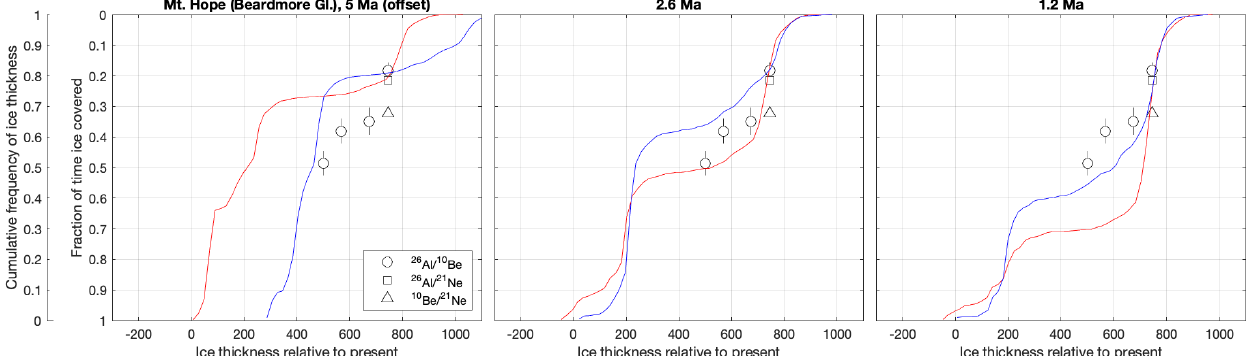
Figure 13. Ice cover frequency estimates for Mt Hope, inferred from multiple-nuclide data and the inversion code of Spector et al. (2020), compared with sensitized and desensitized model CDFs for a site in the centre of the model Beardmore Glacier at a position near Mt Hope (because of the coarse model resolution, the model Beardmore Glacier is not in exactly the same location as the real glacier, so we have chosen an equivalent site in the model). As in Figs. 10 and 11, model CDFs have been offset to align observational and model CDFs at the 80th percentile elevation. The data from Mt Hope are unpublished measurements archived in the ICE-D: ANTARCTICA